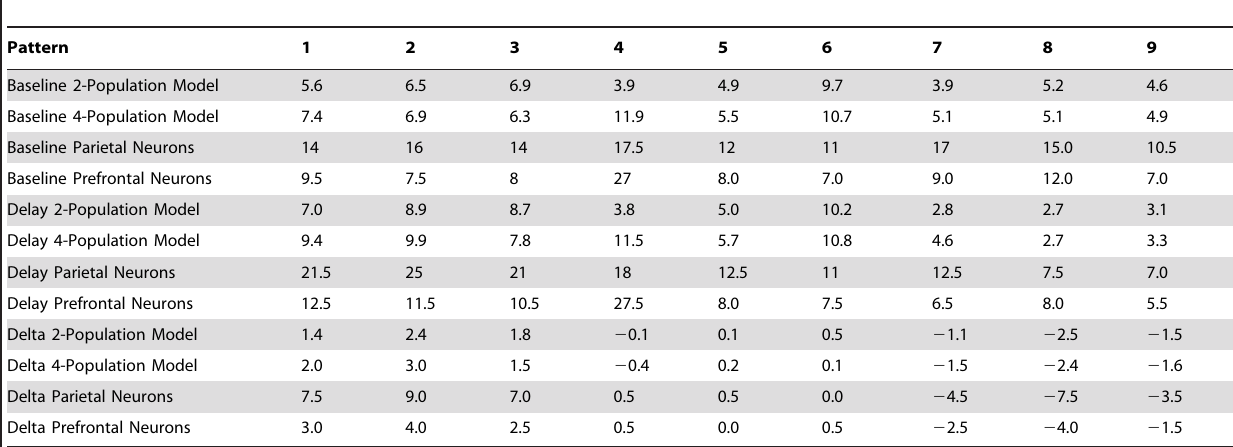
Table 4. Average firing frequencies (Hz) during the baseline and delay periods, and the frequency difference between baseline and the average of the delay period (delta), for the units exhibiting each of the pattern types by the 2- and 4-population spiking